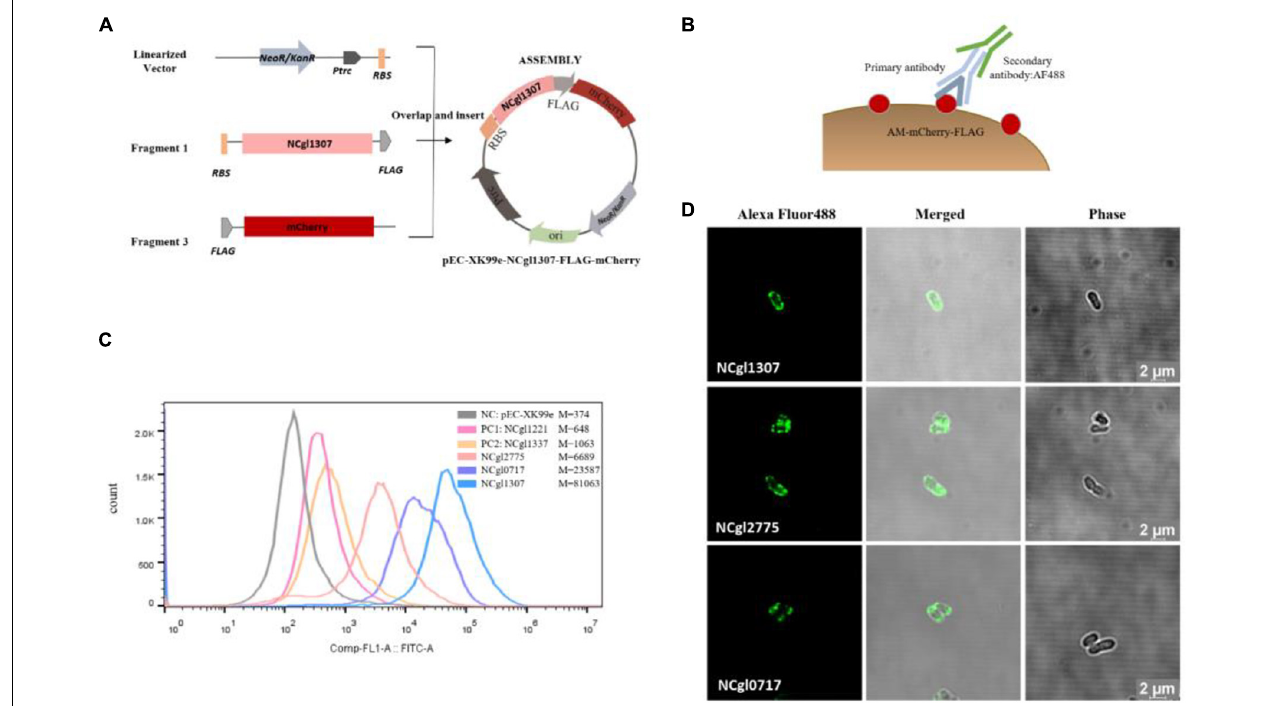
FIGURE 2 | Screening and confirmation of anchoring protein display on the cell surface by displaying mCherry. (A) Construction of recombinant Corynebacterium glutamicum surface display system with mCherry as passenger protein. Take the construction of Ncgl1307-mCherry as an example. Using mCherry gene as template and mCherry-pEC F and mCherry-pEC R as primers, mCherry gene fragment 3 was amplified. Then, Seamless Assembly Cloning Kit was used to assemble fragment 1, fragment 3, and linearized vector ( Figure 1A ). (B) Schematic diagram of the immunofluorescence reaction. Anti-flag monoclonal antibody and Alexa Fluor 488-labeled antibody were added to the mCherry-FLAG. (C) Flow cytometry analysis. The peak figures of different colors from left to right represent the fluorescent signal intensities of cells harboring pEC-XK99e, Ncgl1221-mCherry, Ncgl1337-mCherry, NCgl2775-mCherry, NCgl0717-mCherry, or NCgl1307-mCherry, respectively. Of these, cells harboring pEC-XK99e were the negative control (NC − mCherry ), and cells harboring Ncgl1221-mCherry and Ncgl1337-mCherry were the positive control 1 (PC1 − mCherry ) and the positive control 2 (PC2 − mCherry ), respectively. M is the mean value of Comp-FL-A:FITC-A_Area. (D) Image observed on a confocal microscope. The green fluorescence comes from the fluorescence of the Alexa Fluor 488-labeled antibody on the flag label (488 nm—excitation, 520 nm—emission).